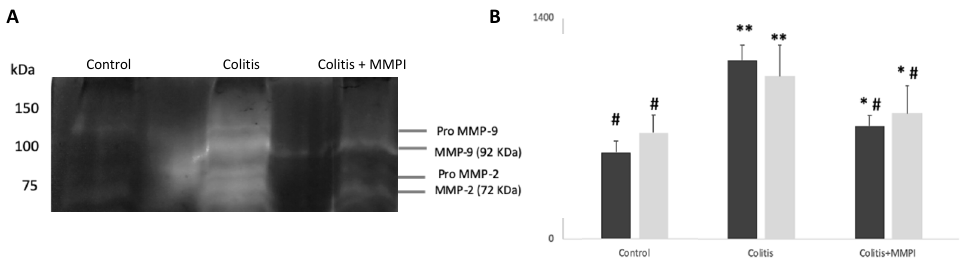
Figure 5. Effect of the L. albus MMPI administration on the colon tissue gelatinase activities of MMP-2 and MMP-9 from colitis-induced mice. ( A ): Representative image of the zymographic profiles of MMP-9 and MMP-2 activities of the colons. Protein extracts of the colon were loaded on 12.5% ( w / v acrylamide) polyacrylamide gels co-polymerized with 1% ( w / v ) gelatin. ( B ): Densitometric analysis of the gelatinolytic activity of MMP-9 and MMP-2 obtained in the zymographies. Control group ( n = 6); Colitis group ( n = 10); Colitis + MMPI =colon from animals treated with L. albus MMPI (15 mg·kg − 1 , n = 9, p.o.). Results are average of at least three replicates. # p < 0.05 vs. Colitis; * p < 0.05 vs. Control and ** p < 0.001 vs. Control.